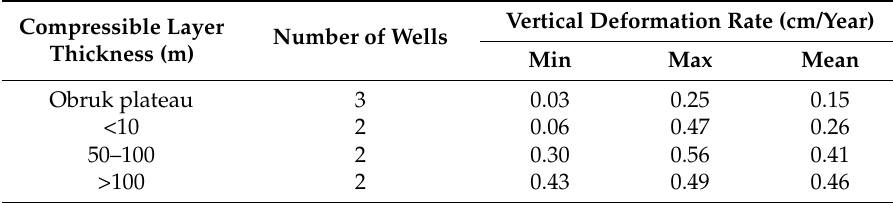
Figure 10. ( A ) Simplified geological profile (see Figure 9 for location) vs. ( B ) profile of DInSAR vertical deformation rate. The groundwater level for 2002 and 2010 is estimated from the nearest piezometric well (ID 52258). Table 10. Vertical deformation rate in relation to thickness of compressible layers. Table 10. Vertical deformation rate in relation to thickness of compressible